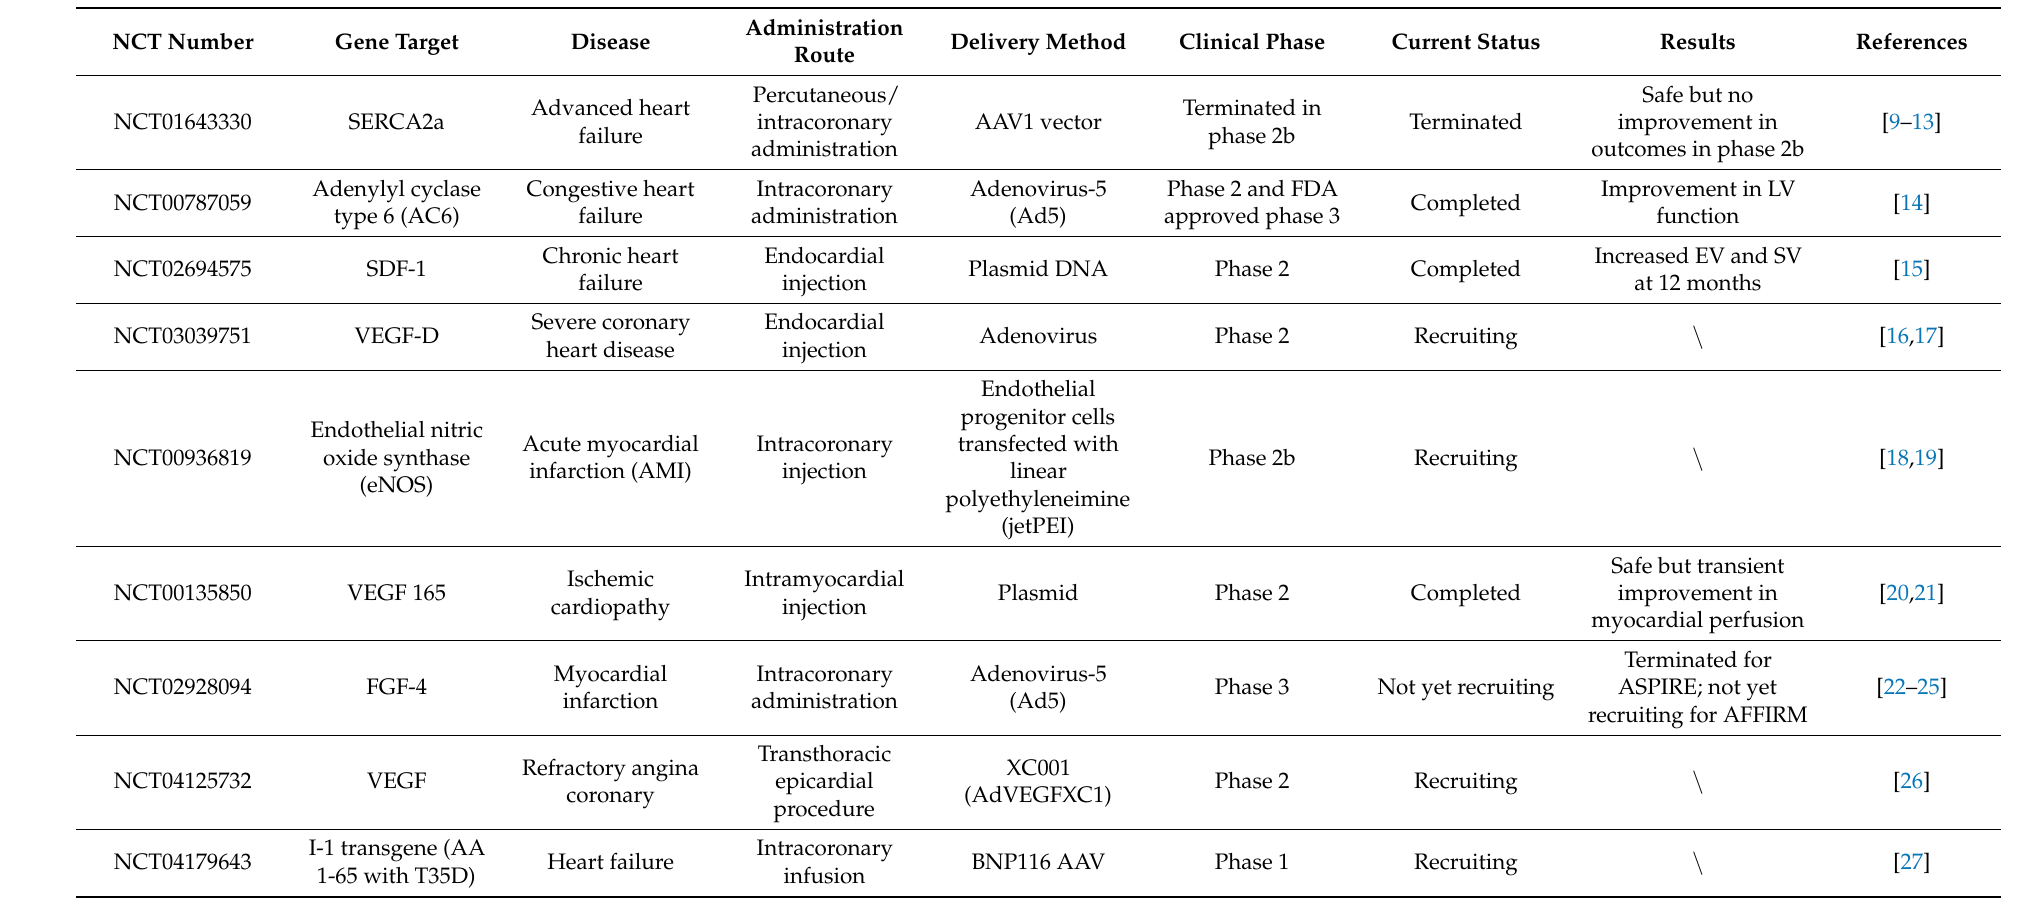
Table 1. Gene therapy in clinical trials to treat heart